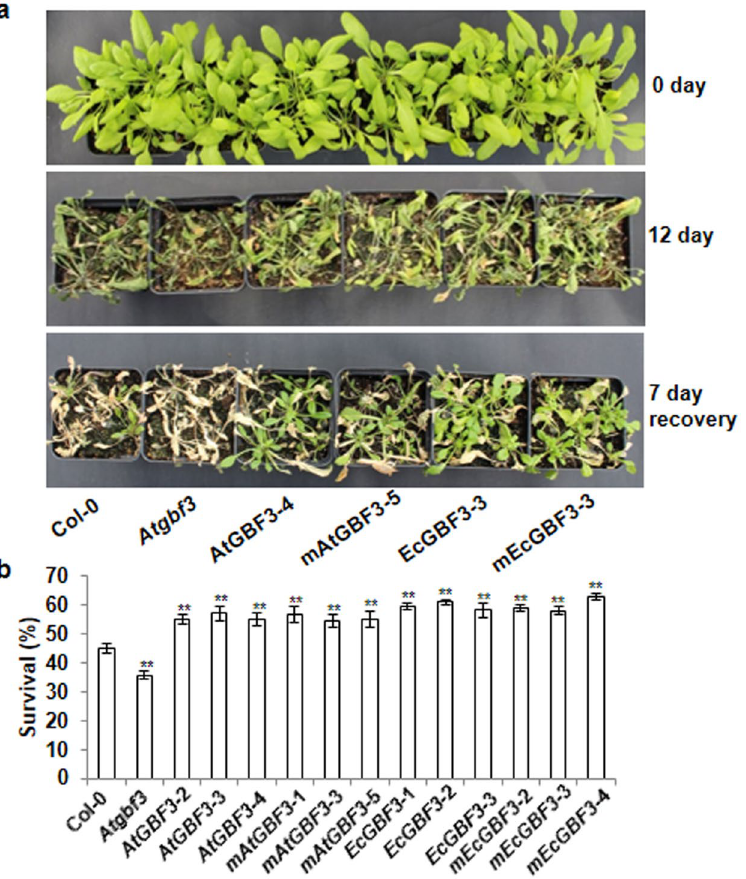
Figure 6. Enhanced drought tolerance of AtGBF3 and EcGBF3 transgenic plants. Drought stress was applied by stopping water on three week old plants for 12 days followed by re-watering for recovery. Phenotype of plants at 0 day drought, 12 days drought and a week after re-watering ( a ) and Seedling survival as determined by counting the number of plants with at least one newly grown leaf at the end of recovery period ( b ). The values are means ± SE (n = 10). t test was used to show the statistical significance of the differences in the means of Atgbf3 mutant or transgenic plants from Col-0 plants. * and ** indicate significant difference from Col-0 plants at P ≤ 0.05 and P ≤ 0.01, respectively. Atgbf3 , AtGBF3 mutant; AtGBF3 -2, -3 and -4, transgenic lines overexpressing AtGBF3 ; mAtGBF3 -1, 3 and -5, transgenic lines overexpressing AtGBF3 in the Atgbf3 mutant background; EcGBF3 -1, 2 and 3, transgenic lines overexpressing EcGBF3 ; mEcGBF3 -2, 3 and 4, transgenic lines overexpressing EcGBF3 in the Atgbf3 mutant background.